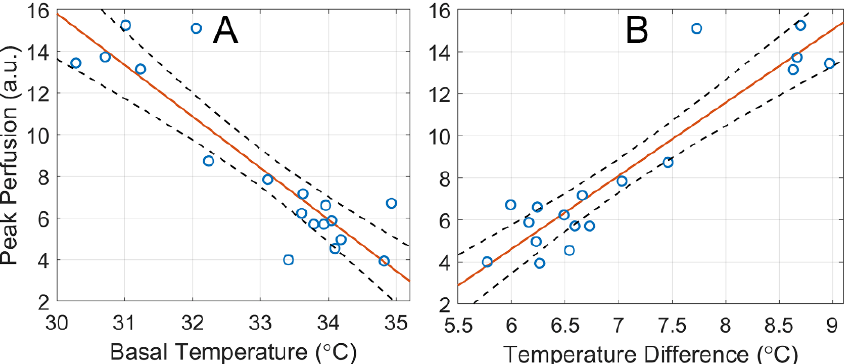
Figure 7. Dependence of the maximum increase ( K max ) in the perfusion index during the first phase of the vascular reaction on the initial temperature T bsl (graph ( A )), and on the temperature difference ∆ T (graph ( B )). Blue circles show the measured values, the red line is the best fit for the data, and black dashed curves represent a 95% confidence interval for the regression line.